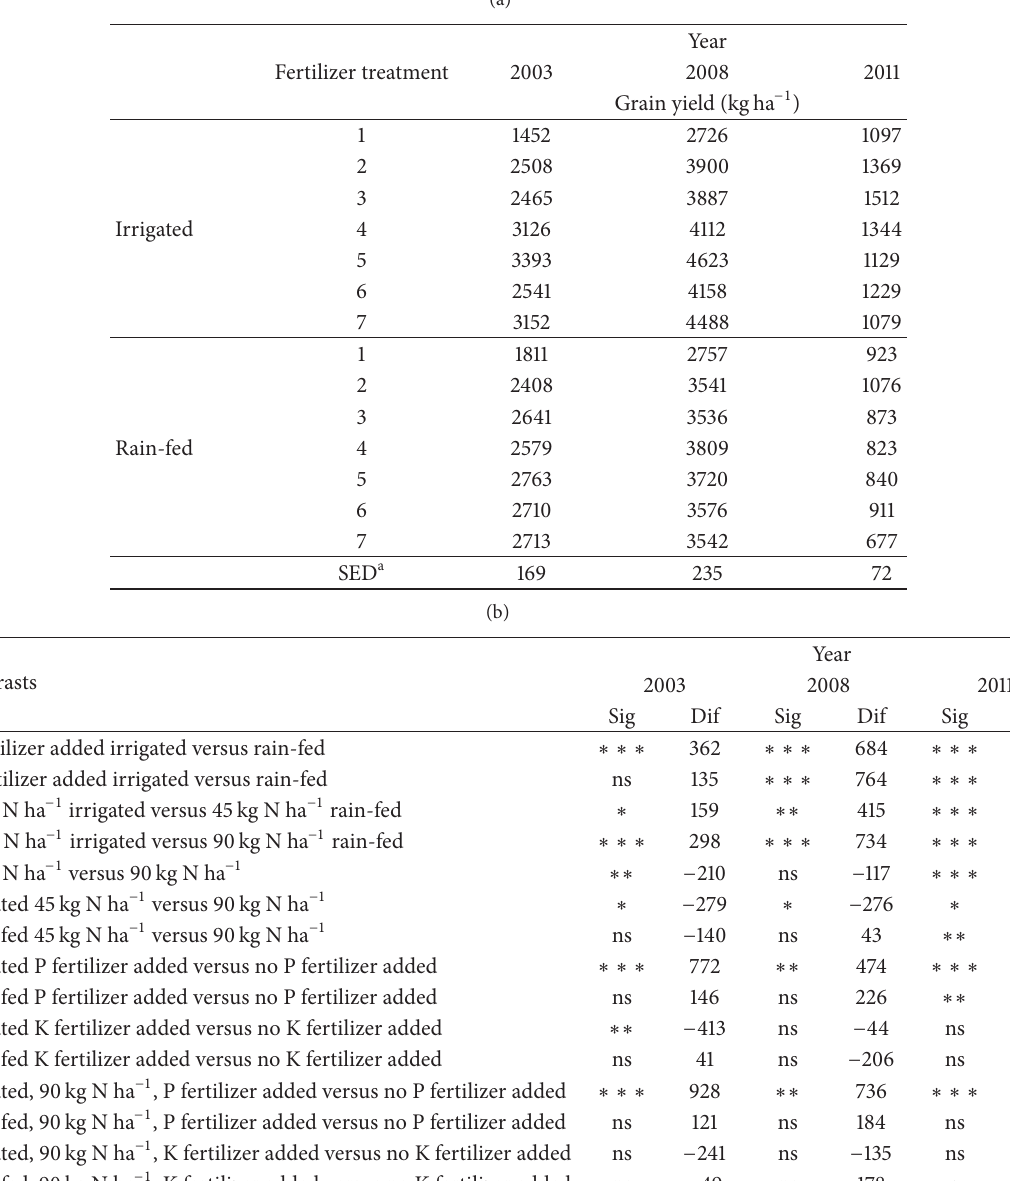
Table 6: Grain yield means and selected contrasts by year for plots with different fertilizer treatments and those either received a flush of irrigation prior to planting or did not receive irrigation.